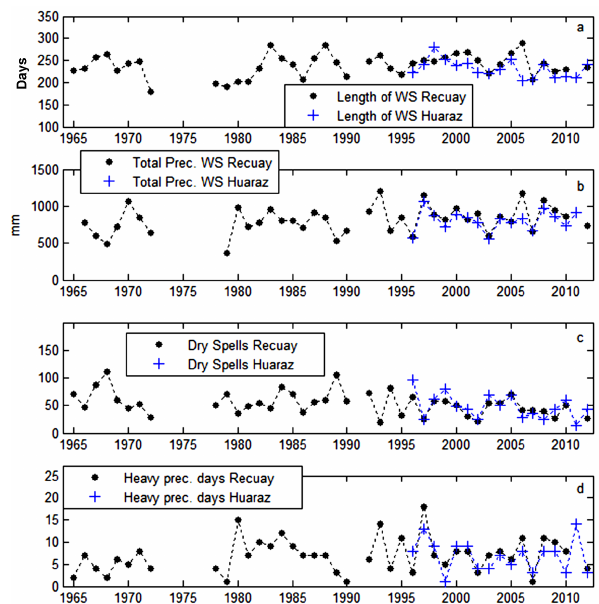
Figure 4. Time series of (a) the length of the wet season (for the agricultural years starting in the year shown on the y axis), (b) the total precipitation during the wet season (for the exceptional year 1991 no wet season start could be calculated. Thus, we used the date for the first sowing conditions derived from criterion 3b as the start date of the wet season for this and the following subplots), (c) the frequency of dry spells during the wet season until 23 April (earliest onsets of dry season in Huaraz and Recuay), and (d) the frequency of heavy precipitation days during the wet